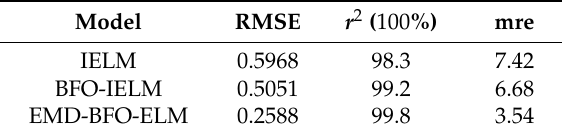
Table 4. The calculation results of the three models.